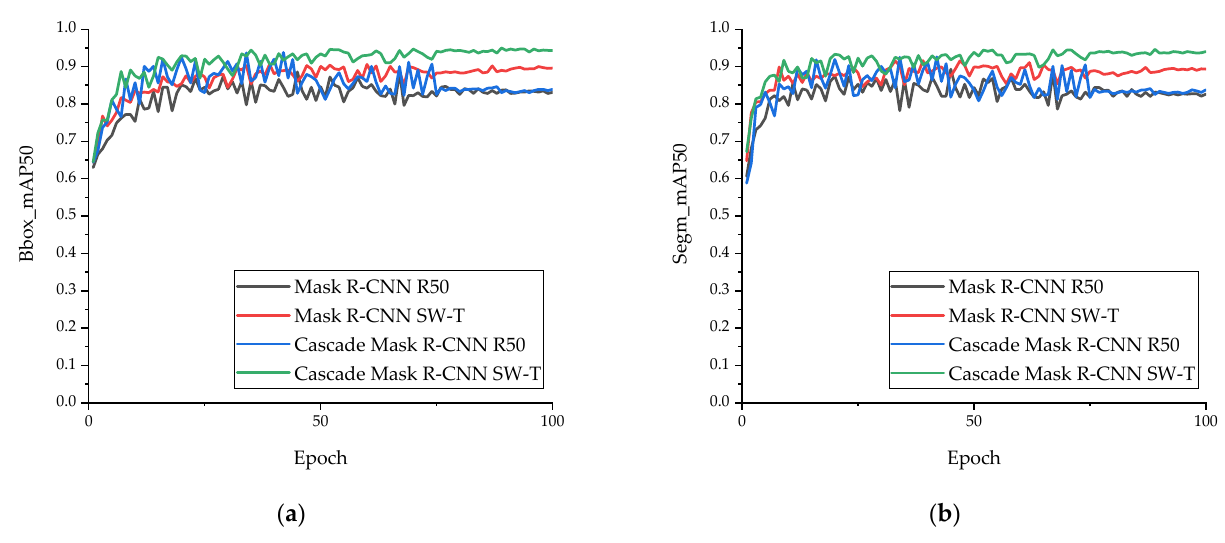
Figure 7. Variation curve of mAP50 of four algorithms with epoch: ( a ) changes in bbox mAP50 with epoch; ( b ) changes in segm mAP50 with epoch.